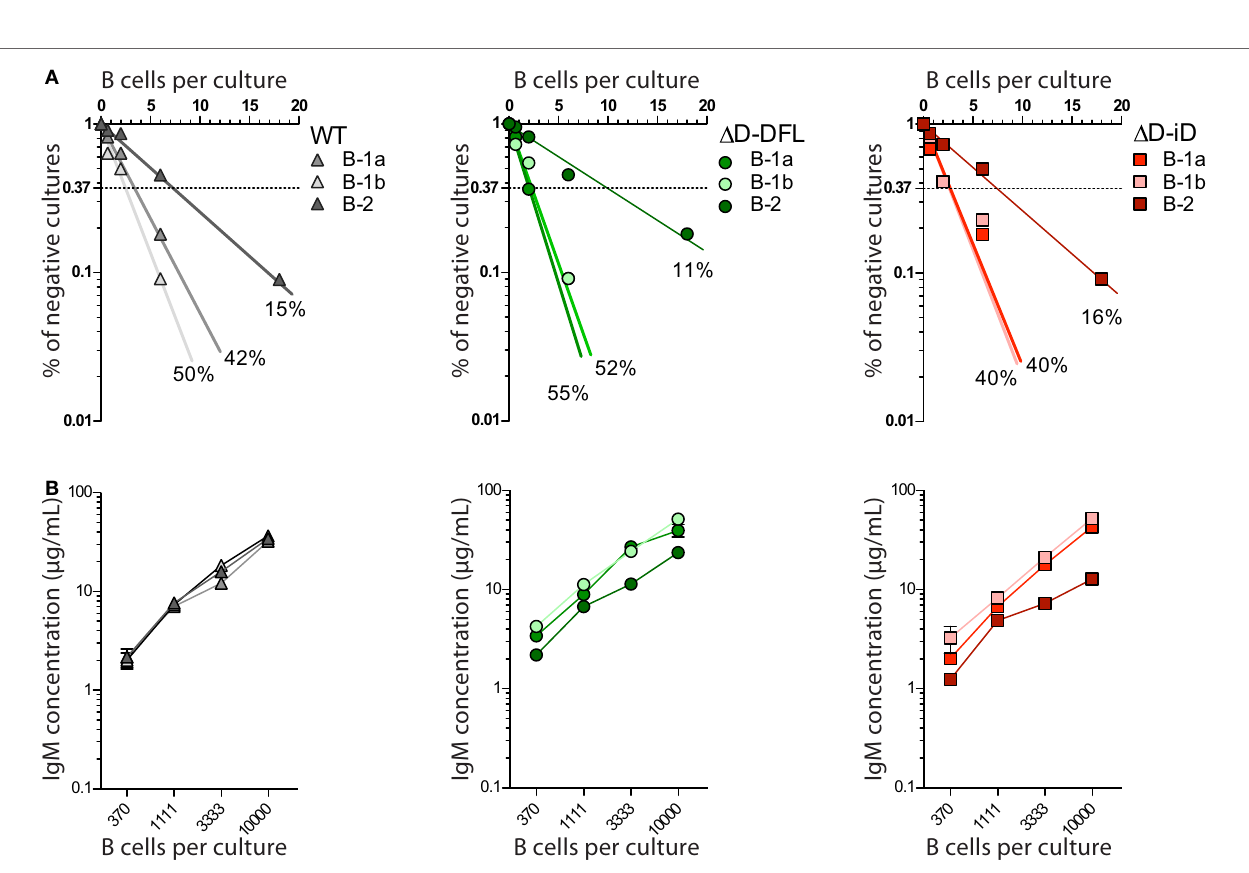
FigUre 1 | serum natural igM pattern of self-reactivity expressed by Δ D-DFl, Δ D-iD, and WT BalB/c mice . (a) Serum IgM reactivities against syngeneic brain extract from five animals of each strain. (B) Total protein staining by colloidal gold densitometric profile was compared to natural IgM recognition profile in the same membrane. (c) Mean serum IgM reactivity profiles of each mouse strain. Raw data adapted from Ref. (25).